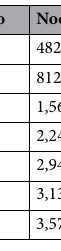
Table 2. Grid independence test for sheet and tube collector.